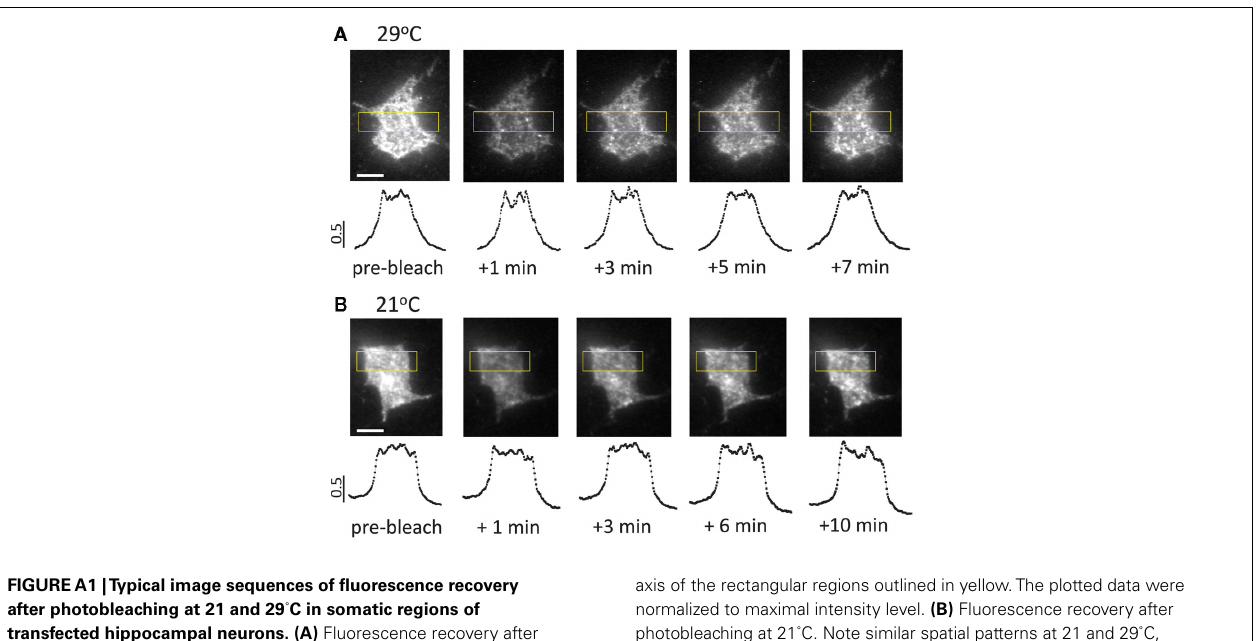
FIGUREA1 |Typical image sequences of fluorescence recovery after photobleaching at 21 and 29 ˚ C in somatic regions of transfected hippocampal neurons. (A) Fluorescence recovery after photobleaching at 29˚C. Note the homogenous distribution of the newly appearing fluorescent clusters contributing to fluorescence recovery. Lower panels show intensity profiles plotted against the long